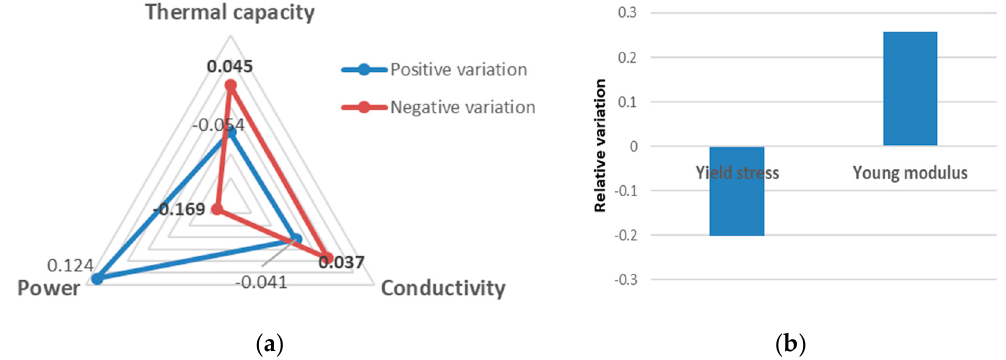
Figure 19. Summary of sensitivity analysis, expressed as the relative variation with respect to the reference case. ( a ) Thermal history sensitivity of the cladded sample with ±20% variations of thermal capacity, conductivity, and power. ( b ) Deflection sensitivity with –20% variation of Young’s modulus and –20% of yield stress.